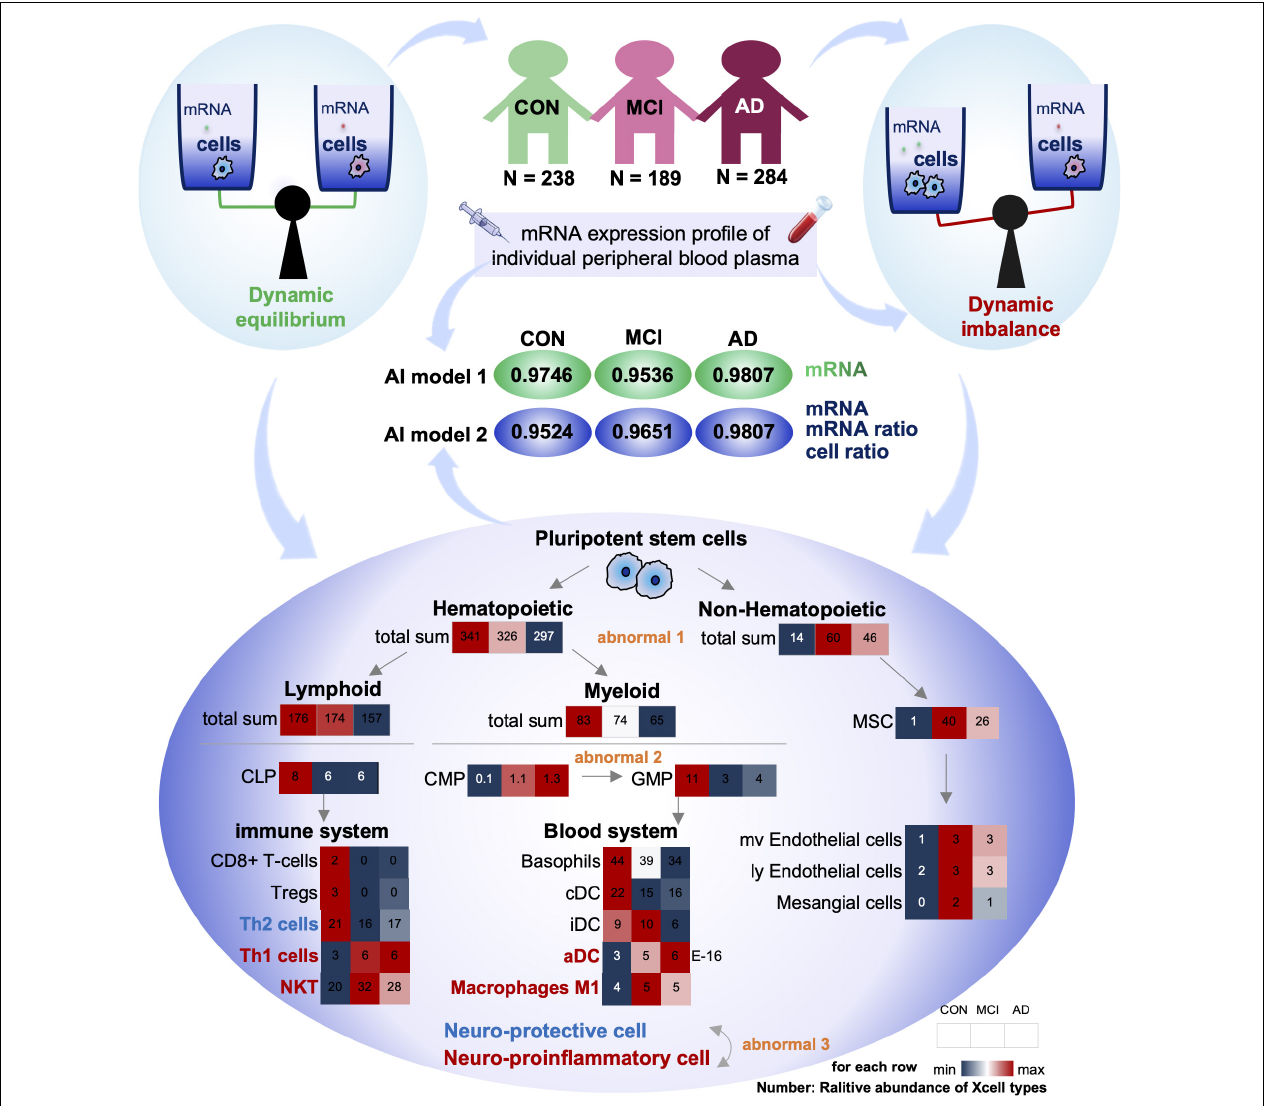
FIGURE 5 | Summary of this study: dysregulation of cell homeostasis during the development of AD. Based on blood mRNA expression profiles, we screened two sets of deep learning models with AUC values greater than 0.95. There was a tripartite imbalance (orange color) in the relative abundance of blood cells in the patients, including a gradual decrease in the ratio of hematopoietic to non-hematopoietic cells, a block in the conversion from CMP to GMP, and a gradual decrease in the ratio of neuroprotective to neuroinflammatory cells. The values in the heat map represent the relative abundance of the XCell median for the disease. Our findings have important implications for both early diagnosis and intervention in MCI and AD.